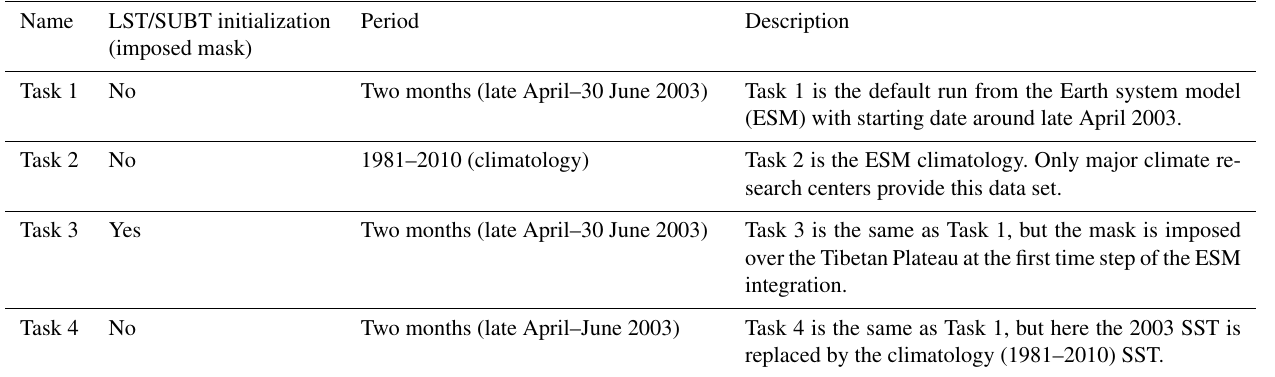
Table 1. Summary of different tasks under the LS4P-I